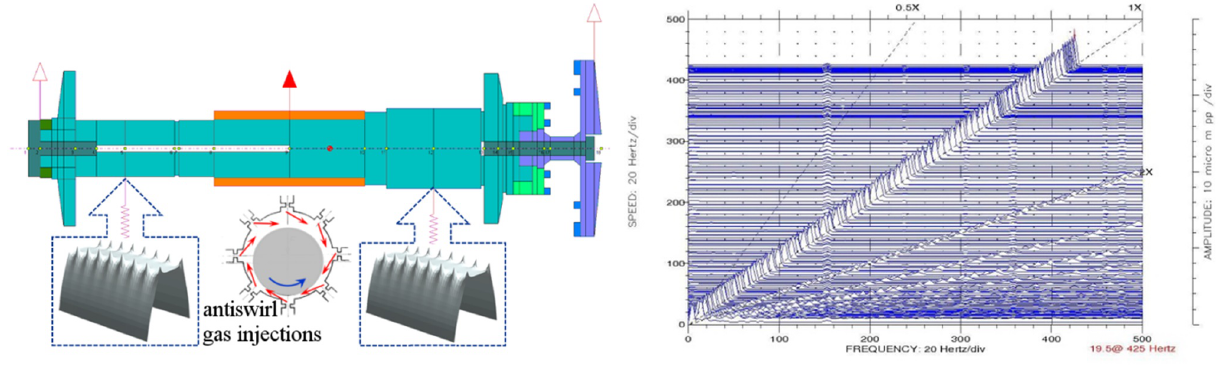
Figure 8: Oil-free turbogenerator prototype test – a cascade plot illustrating the excellent stability of the machine rotating system at the start-up and at the nominal speed